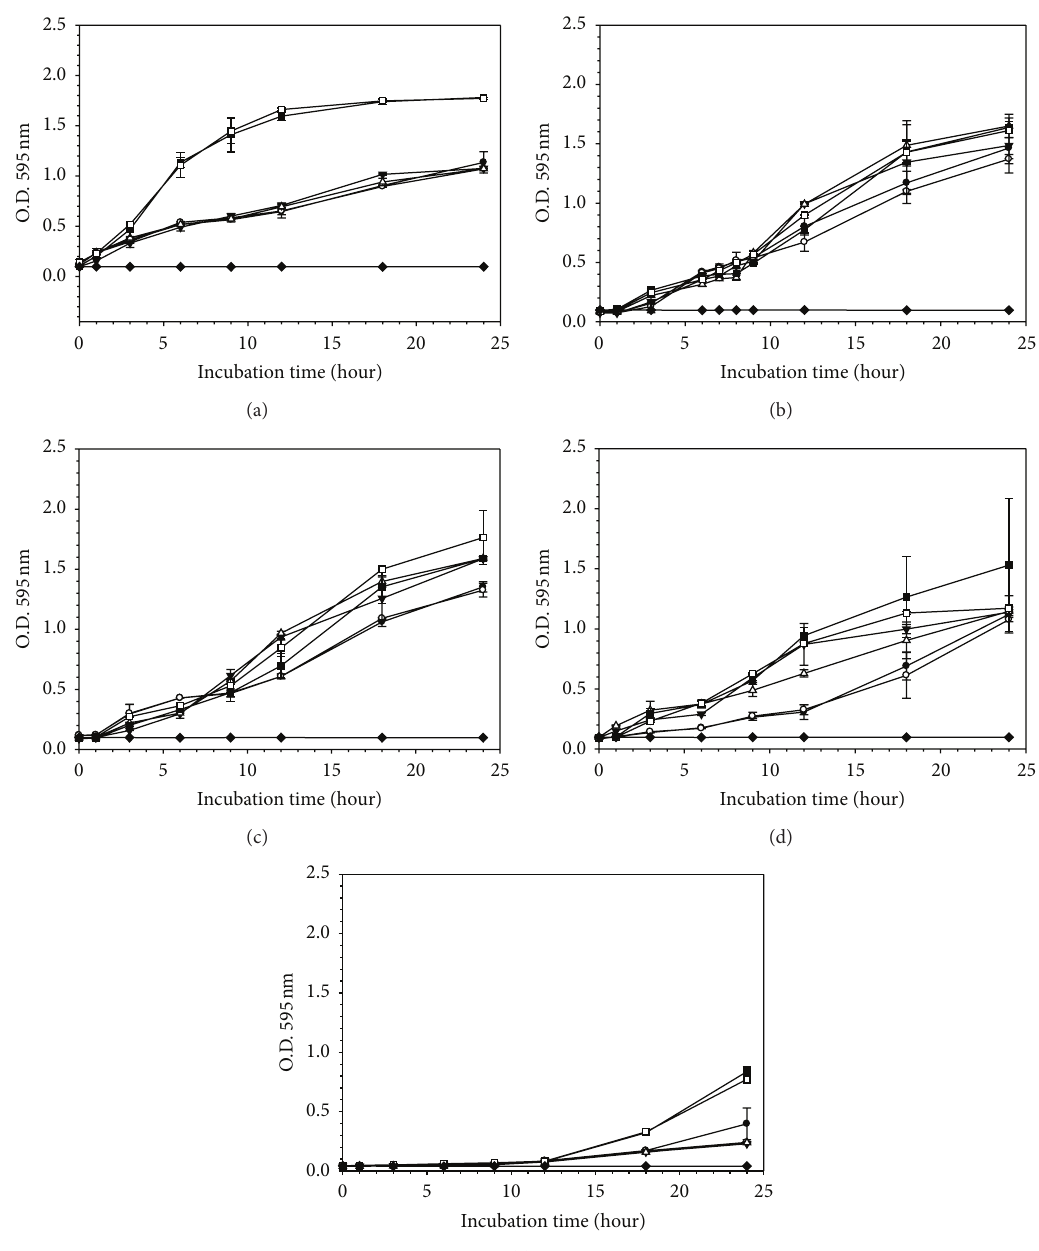
Figure 4: Influence of pH on growth of G. vaginalis (a), L. vaginalis (b), L. gasseri (c), L. plantarum (d), and L. acidophilus (e). Microbial growth was evaluated in media with pH altered to the average pH of the gels (4.5) by HCl ( ∙ , I ), lactic acid ( 󳵳 , Δ ), and normal growth medium ( ◼ , ◻ ) (MRS for lactobacilli spp. and BHI + 3% HS for G. vaginalis ). Sterile broth ( ⧫ ) was also shown as negative control. Data were collected hourly (shown only 0, 1, 3, 6, 9, 12, 18, and 24 h measurements). Experiments were conducted twice in